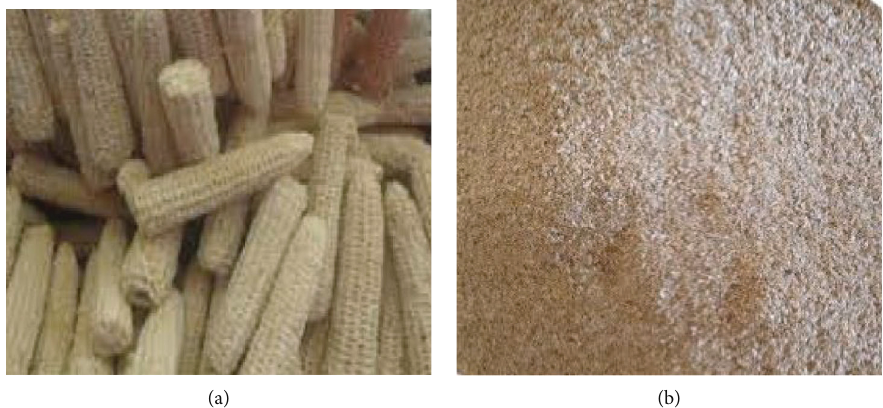
Figure 1: Raw corn cob samples: (a) before crushing and grinding and (b) after